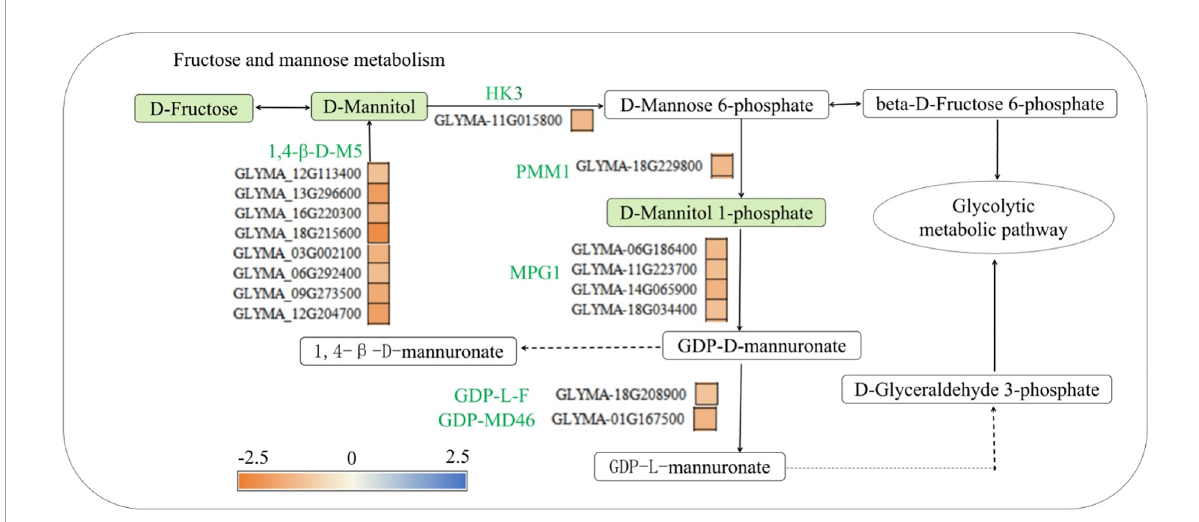
FIGURE9 Fructose and mannose metabolic pathways involved in phosphorus synthesis in soybean roots. HK3, hexokinase 3, PMM1, phosphomannose mutase 1, MPG1, mannose-1-phosphoguanylate transferase, GM46D, GDP-mannose 4, 6 Dehydratase; GLF, GDP-L-fucose synthase; 1,4- β -D-M5, 1,4- β -mannosidase. Green solid squares indicate downregulated metabolites, red solid squares indicate upregulated metabolites. The red fonts represent upregulated genes, the green fonts represent downregulated genes, the red squares represent upregulated proteins, and the yellow and blue squares represent the fold change of gene